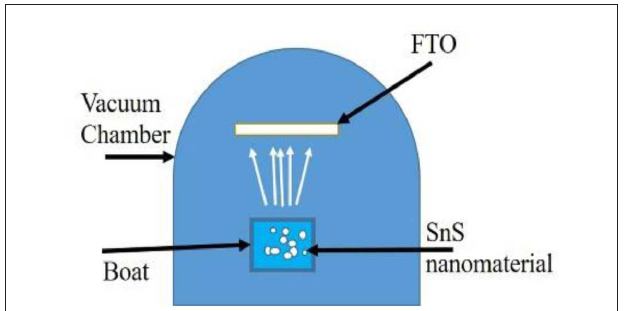
FIGURE 1 | Schematic of thermal evaporation in a RHU used to deposite SnS thin film on FTO.